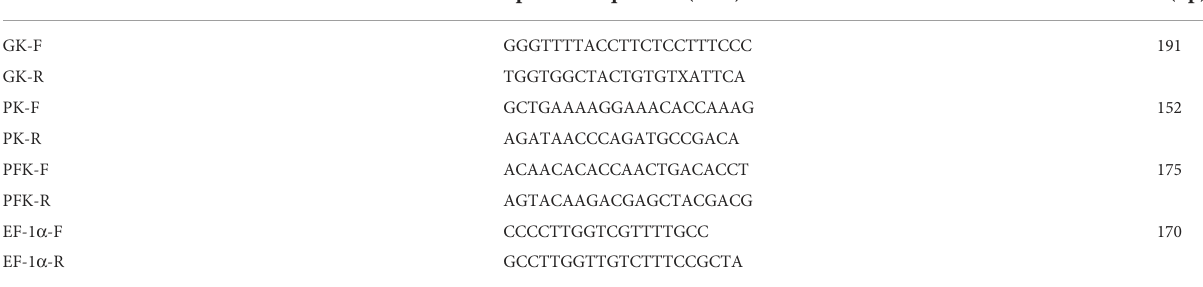
TABLE 5 Primers used in this